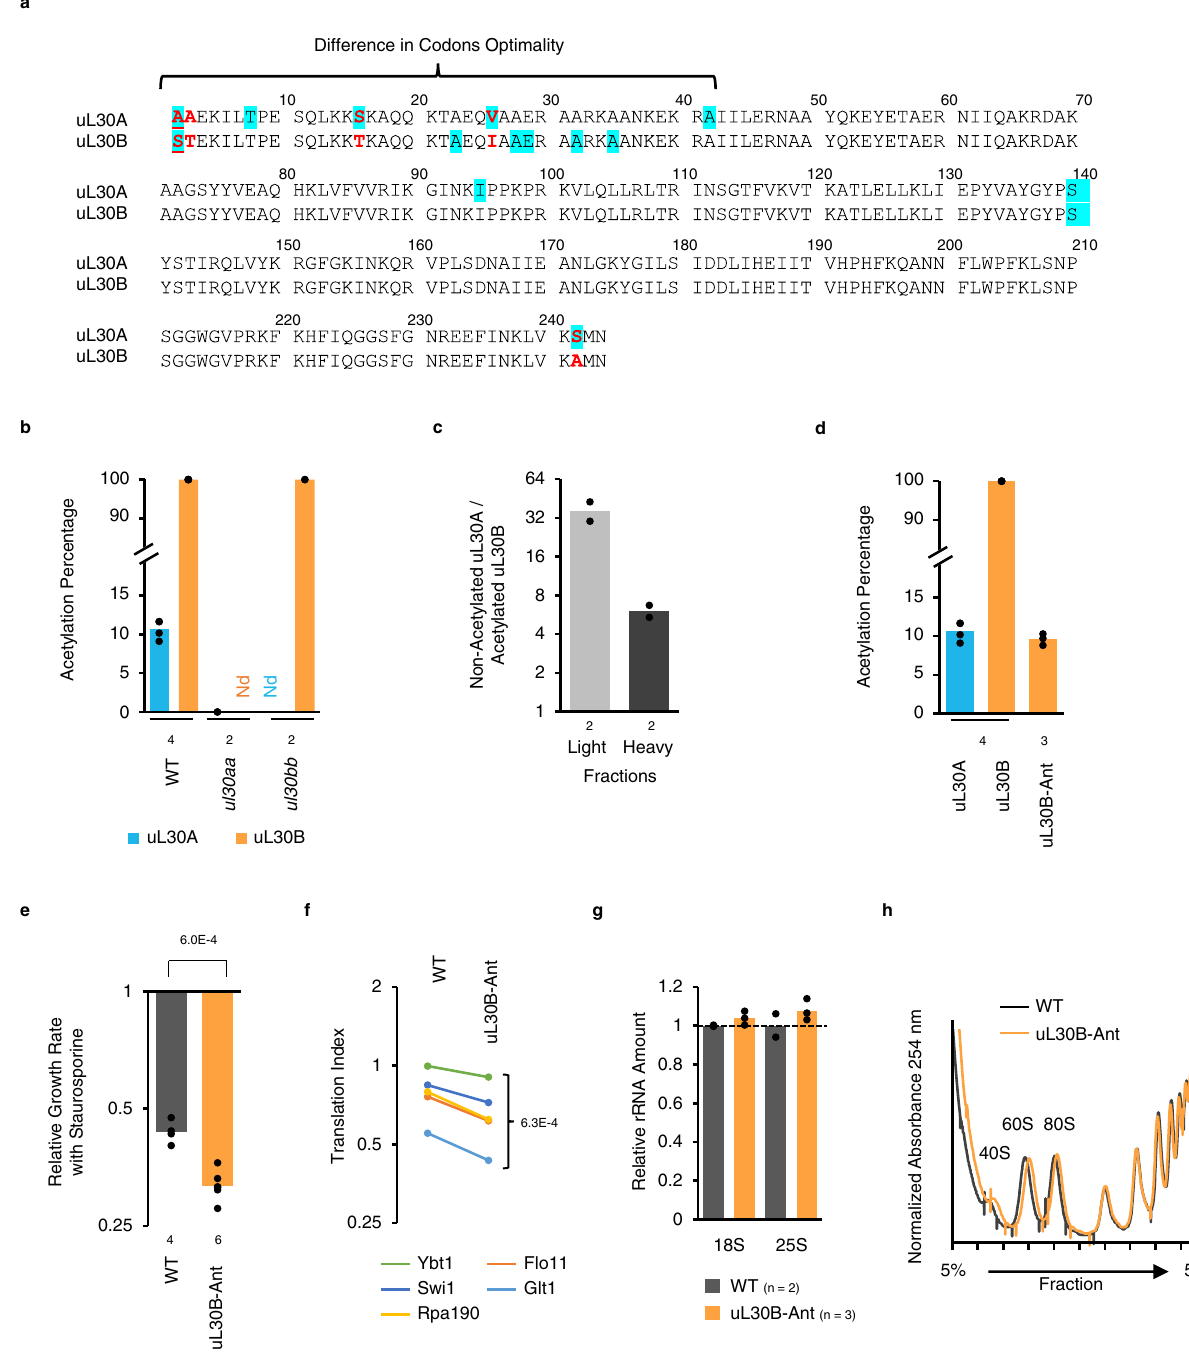
Fig.6|Post-translationmodi fi cationaltersfunctionofuL30paralogs.a Amino acid sequences of uL30 paralogs were aligned using Clustal/W2. Different amino acids are indicated in red, amino acids encoded by suboptimal codon are high- lighted in cyan and position of N-terminal acetylation is underlined. b N-terminal acetylation was measured by mass spectrometry in wild-type, ul30aa and ul30bb cells. The number of biologically independent samples is indicated at bottom. c N-terminal acetylation level of uL30 proteins detected in light (60S) and heavy (heptamers and heavier) polyribosome fractions in WT cells using mass spectro- metry.Thenumberofbiologicallyindependentsamplesisindicatedatbottom.The ratio of non-acetylated uL30A over acetylated uL30B in each fraction is reported. d N-terminal acetylation was measured by mass spectrometry in wild-type and uL30B-Antmutant.Thenumberofbiologicallyindependentsamplesisindicatedat